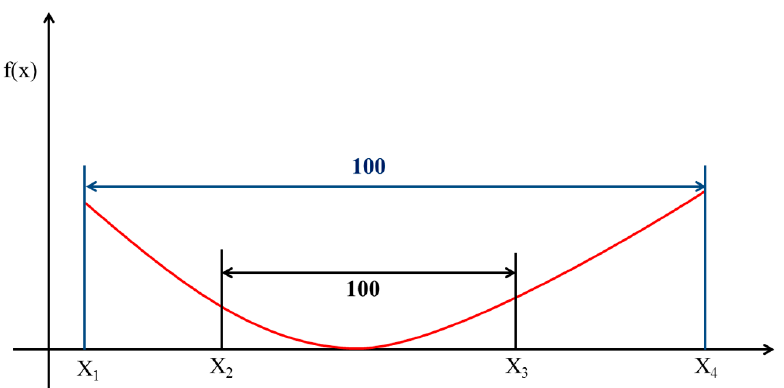
Figure 4. A diagram of the optimal response curve was calculated by the interpolation method and effectively identify contributing data and reduce the computation time during the process.